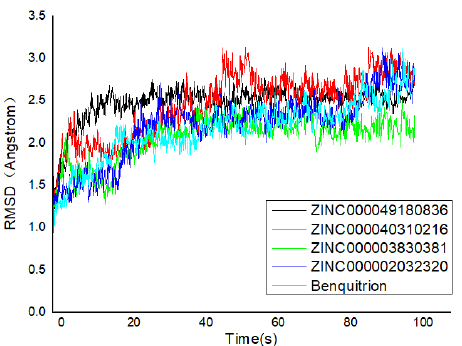
Figure 5. Root mean square deviation (RMSD) trajectories of HPPD–ligand complex during 100-ns simulations.